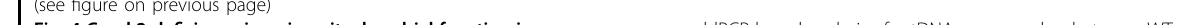
Fig. 4 Cmpk2 de fi ciency impairs mitochondrial function in mouse neurons. a ddPCR-based analysis of mtDNA copy number between WT and Cmpk2 -KO mouse cortex tissues. n = 7~8, three replicates. b Representative images of mitochondria in the primary cultured cortical neurons of WT and Cmpk2 -KO mice with antibodies against the mitochondrial marker ATP synthase β chain (green) and the cytoskeleton protein MAP2 (red); DAPI (blue) was used for nuclear staining. Scale bar, 5 μ m. c Western blot of COX IV and cytochrome C in the WT and Cmpk2 -KO mouse primary cultured cortical neurons. d Quanti fi cation of the change in protein levels of COX IV and cytochrome C. n = 3, three replicates. e Measurement of ATP level of the WT and Cmpk2 -KO mouse neurons. f, g The Pi level in the neuron ( f ), CSF and serum ( g ) in the WT and Cmpk2 -KO mice. h Representative transmission electron micrograph of mitochondria morphology in the primary cultured cortical neurons of WT and Cmpk2 -KO mice. i – k Statistical graphs of cristae coverage ratio of primary cultured cortex neurons in WT and Cmpk2 -KO mice. CC cristae coverage. Error bars indicate means ± SEM. ns not signi fi cant. * P < 0.05, ** P < 0.01, ** *P < 0.001, **** P < 0.0001; Student ’ s t -test. Scale bars, 2 μ m in h , each left panel and 0.2 μ m in h , each right